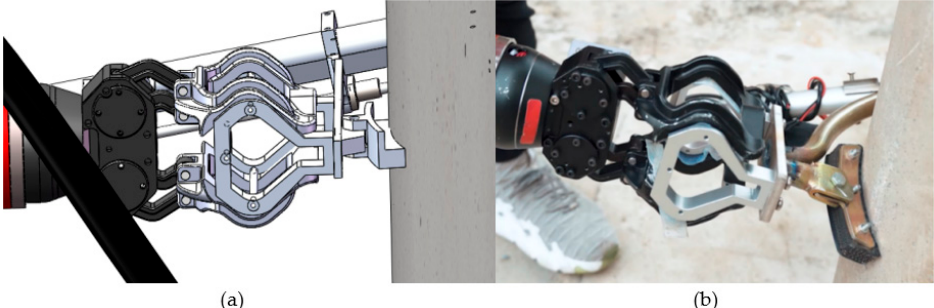
Figure 7. Profile modeling for the small gripper. ( a ) Profile model, ( b ) actual picture.